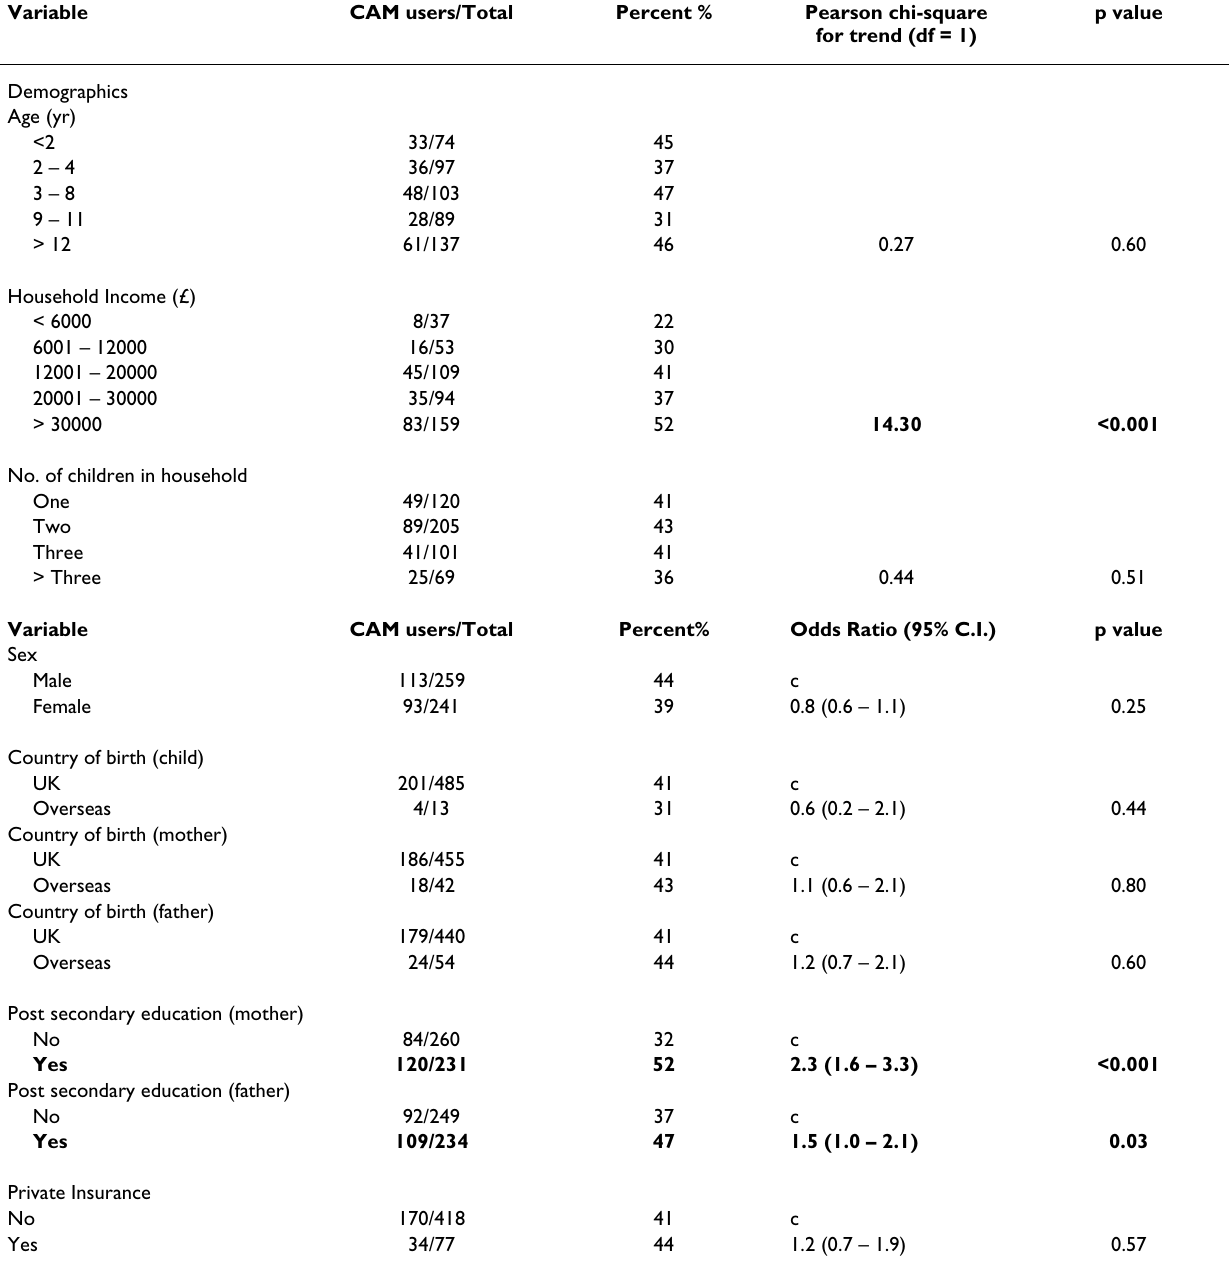
Table 2: Socio-demographic factors associated with CAM use Variable CAM users/Total Percent % Pearson chi-square